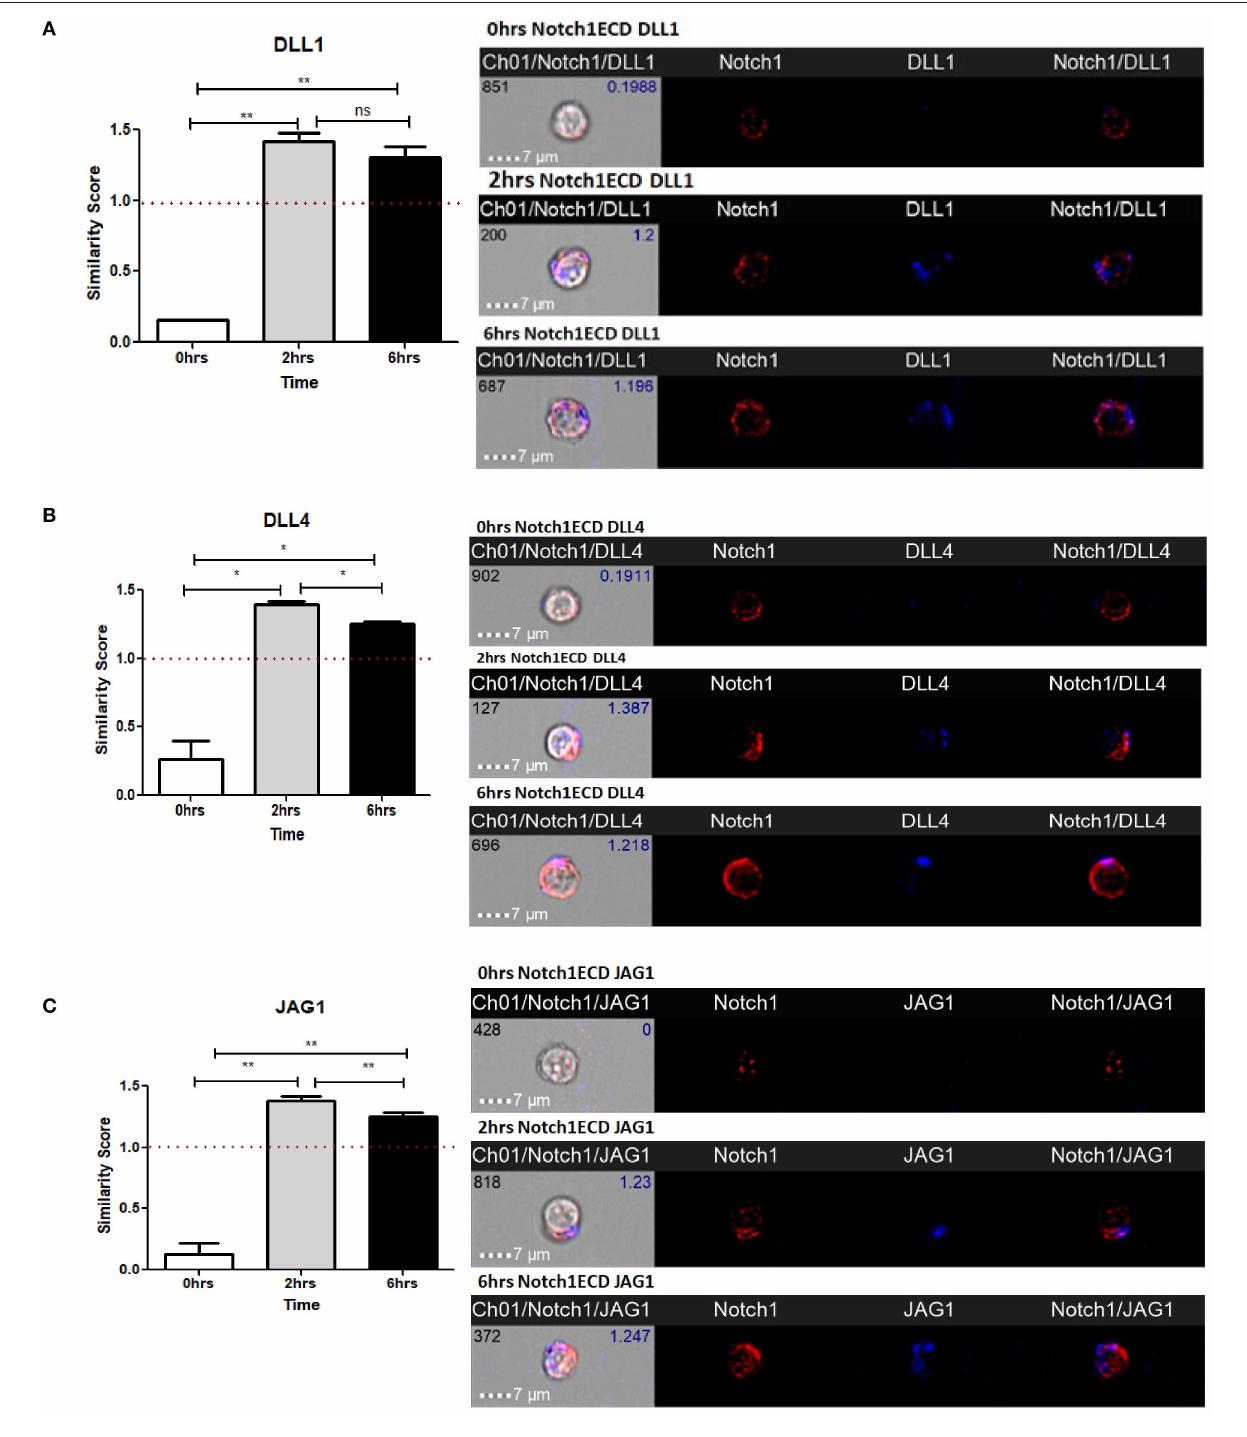
Frontiers in Immunology | www.frontiersin.org